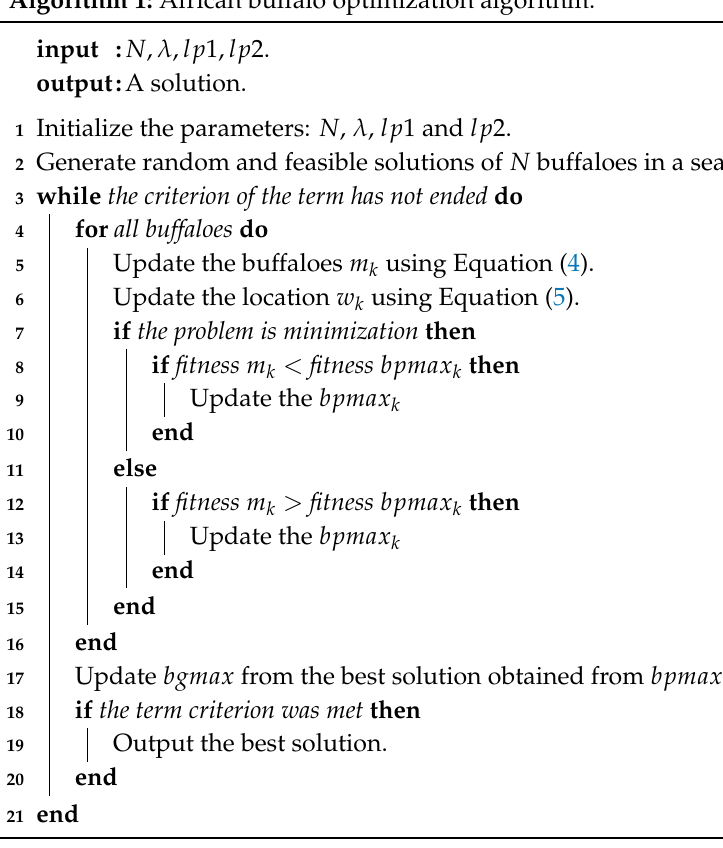
Algorithm 1: African buffalo optimization